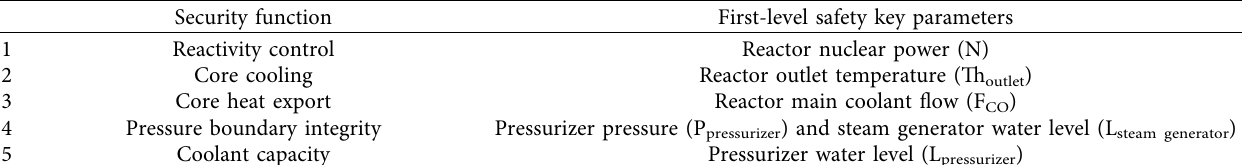
Table 2: The relationship between the safety functions and monitoring parameters.